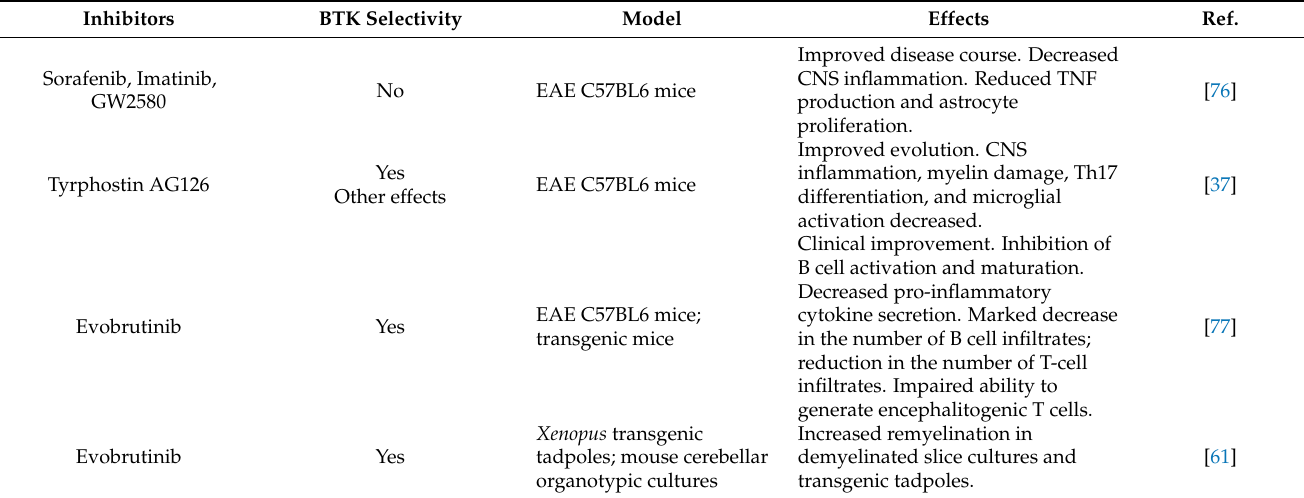
Table 1. Tyrosine kinase inhibition in experimental models of multiple sclerosis. Inhibitors BTK Selectivity Model Effects